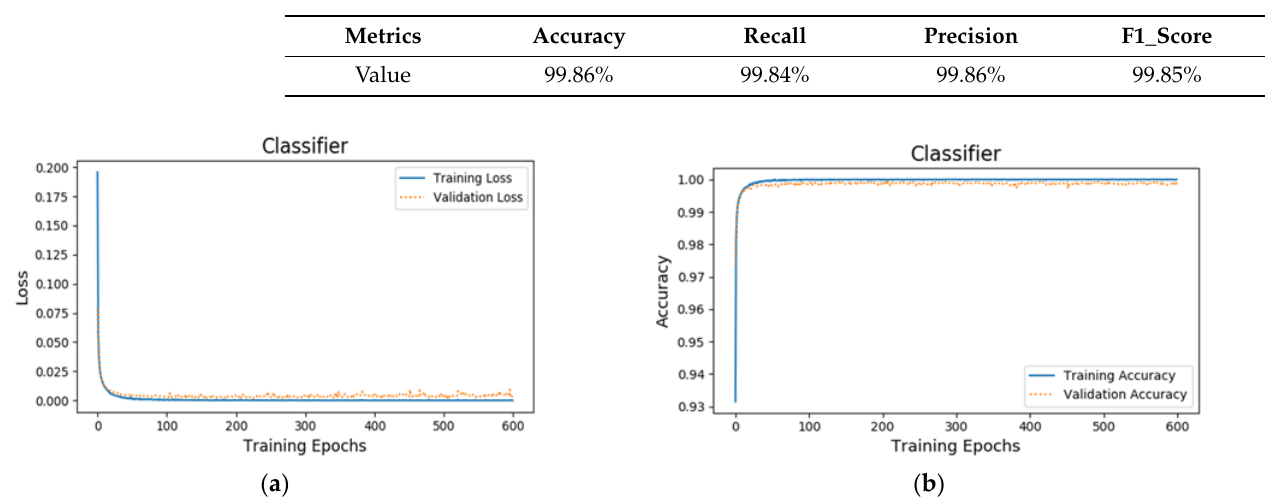
Figure 9. The structure of autoencoder-based deep neural network. Table 7. Recognition performance of door opening.